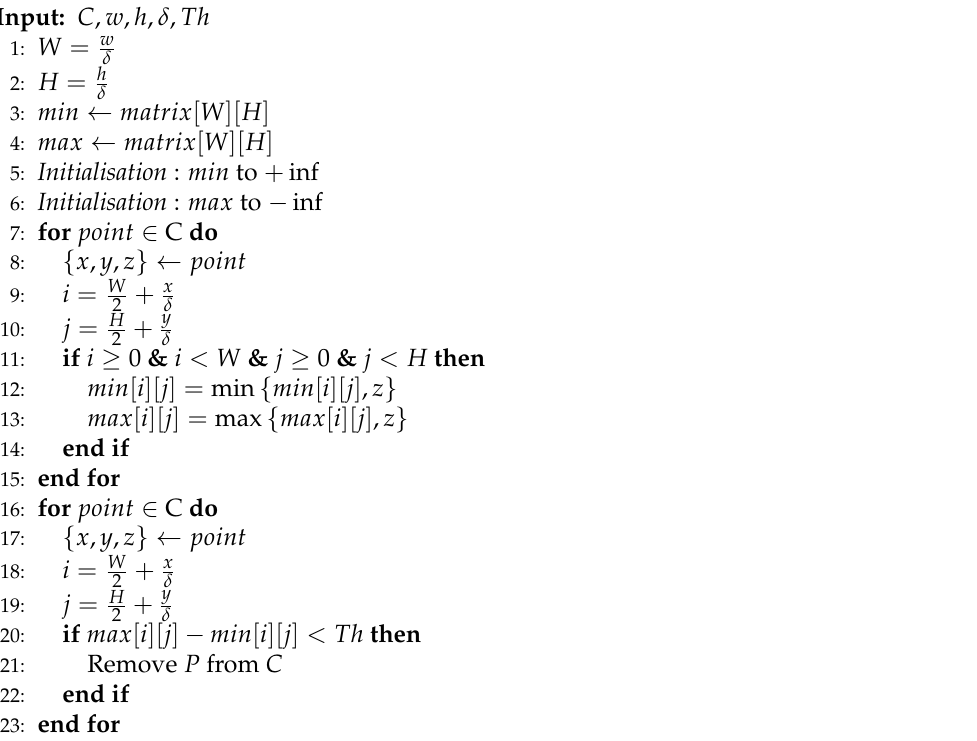
Algorithm 2 Heightmap Algorithm for Ground